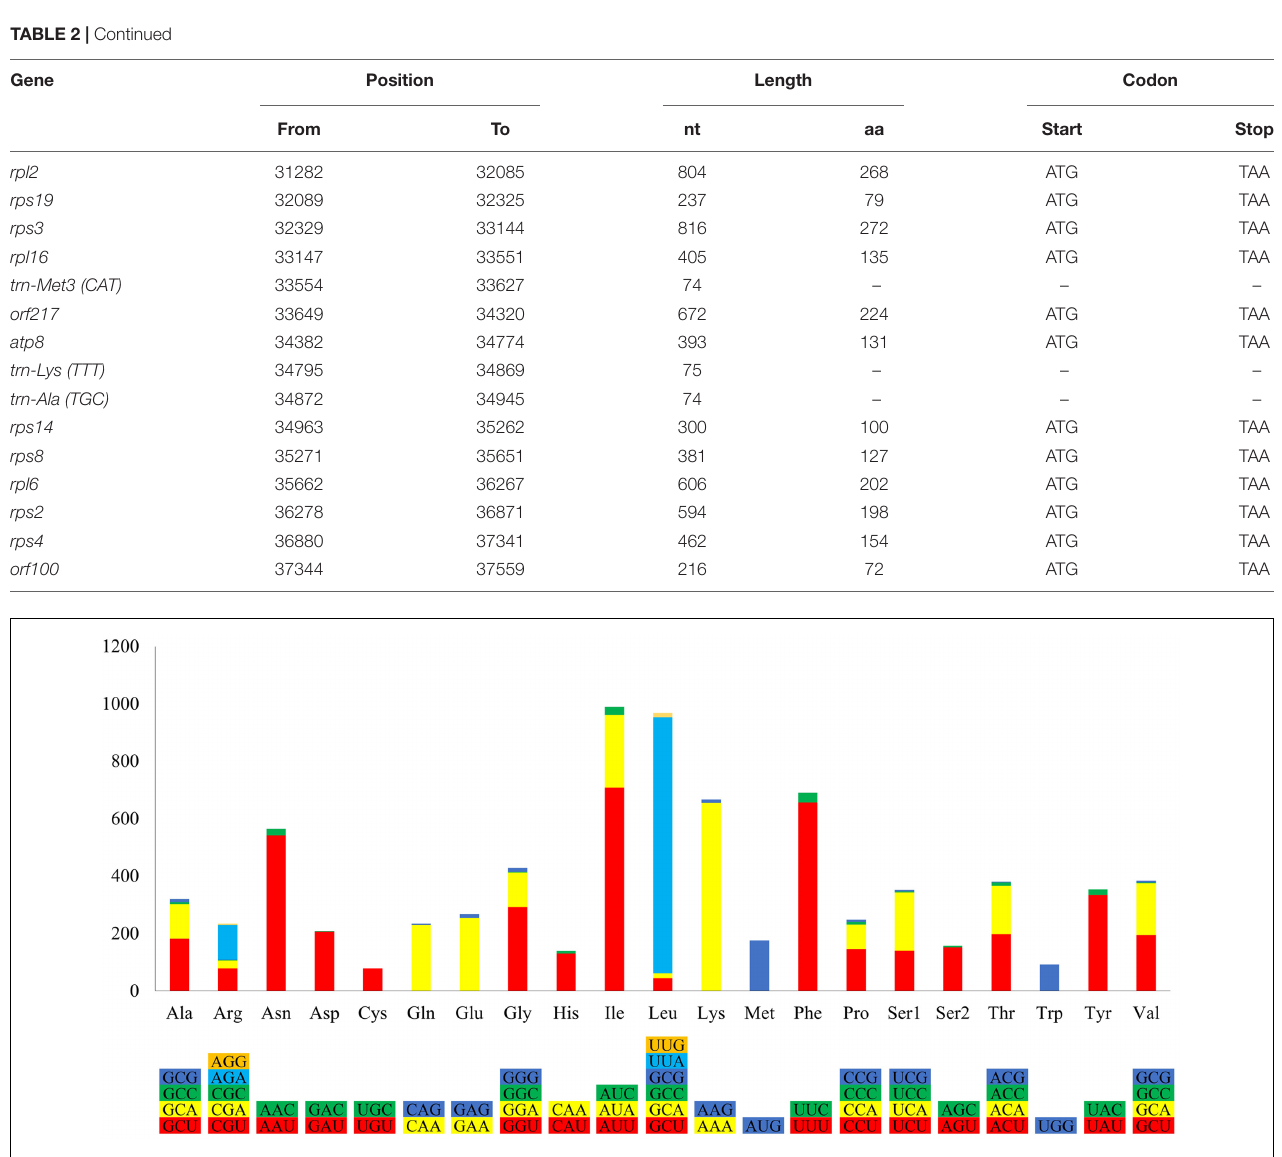
FIGURE 2 | Relative synonymous codon usage of the mitochondrial genome in P. nicotianae. Colorful columns represent the codon usage of the genes in P. nicotianae . The height of columns represents the frequency of utilization of a certain